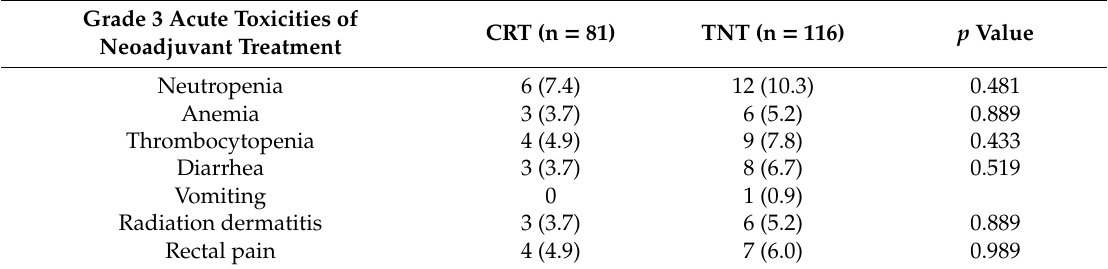
Table 2. Sever Acute Toxicity of Neoadjuvant Treatment.